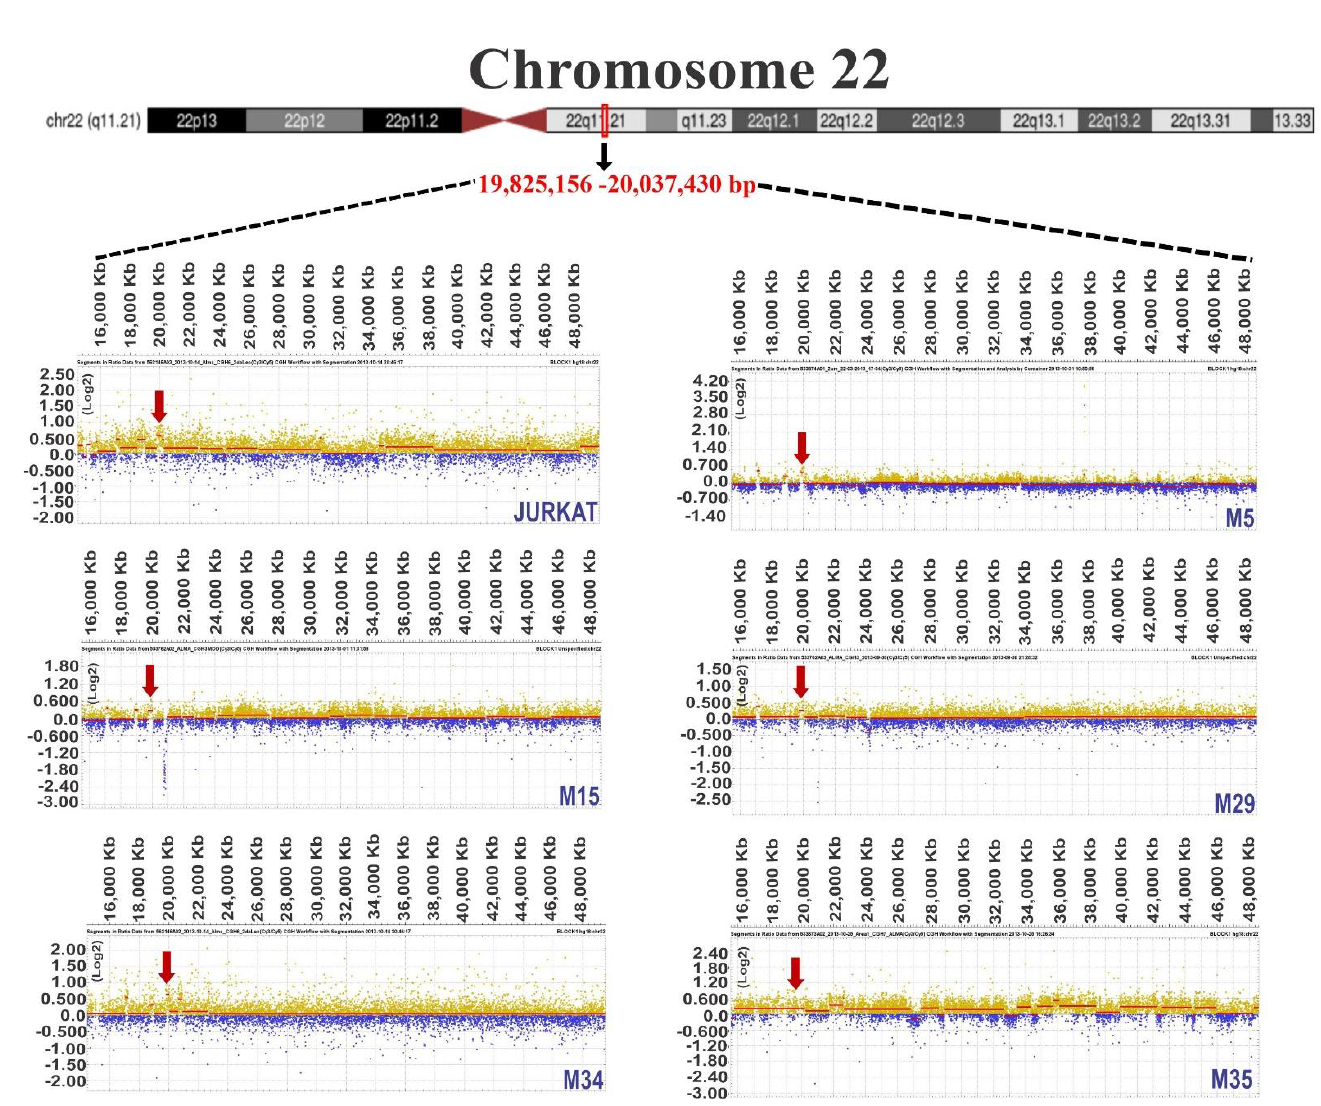
Figure 3. Comparative genomic hybridization images of gains observed for chromosome 22. The ideogram for chromosome 22 shows the common gain region on the q11.21 arm with dashed lines. Representative images of each patient or cell line were obtained with DEVA software; gains are indicated by red arrows, and signal intensity values (ratios) were normalized to Log2. The size scale is shown in megabases (Mb). The patient ID is included in the lower-right margin of each image.